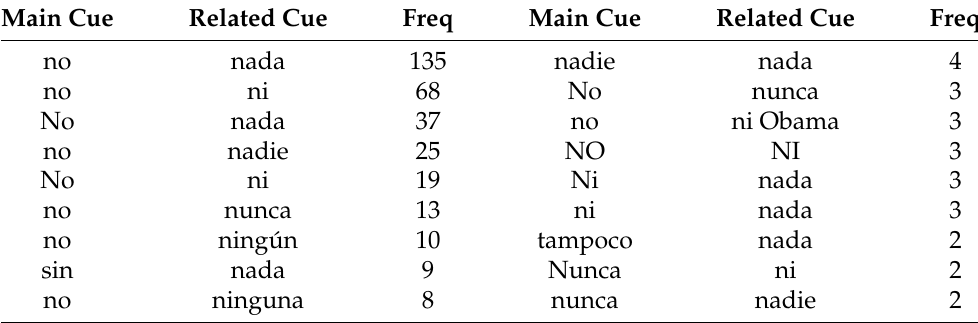
Table A3. Related negation cues distribution taking into account words with more than one